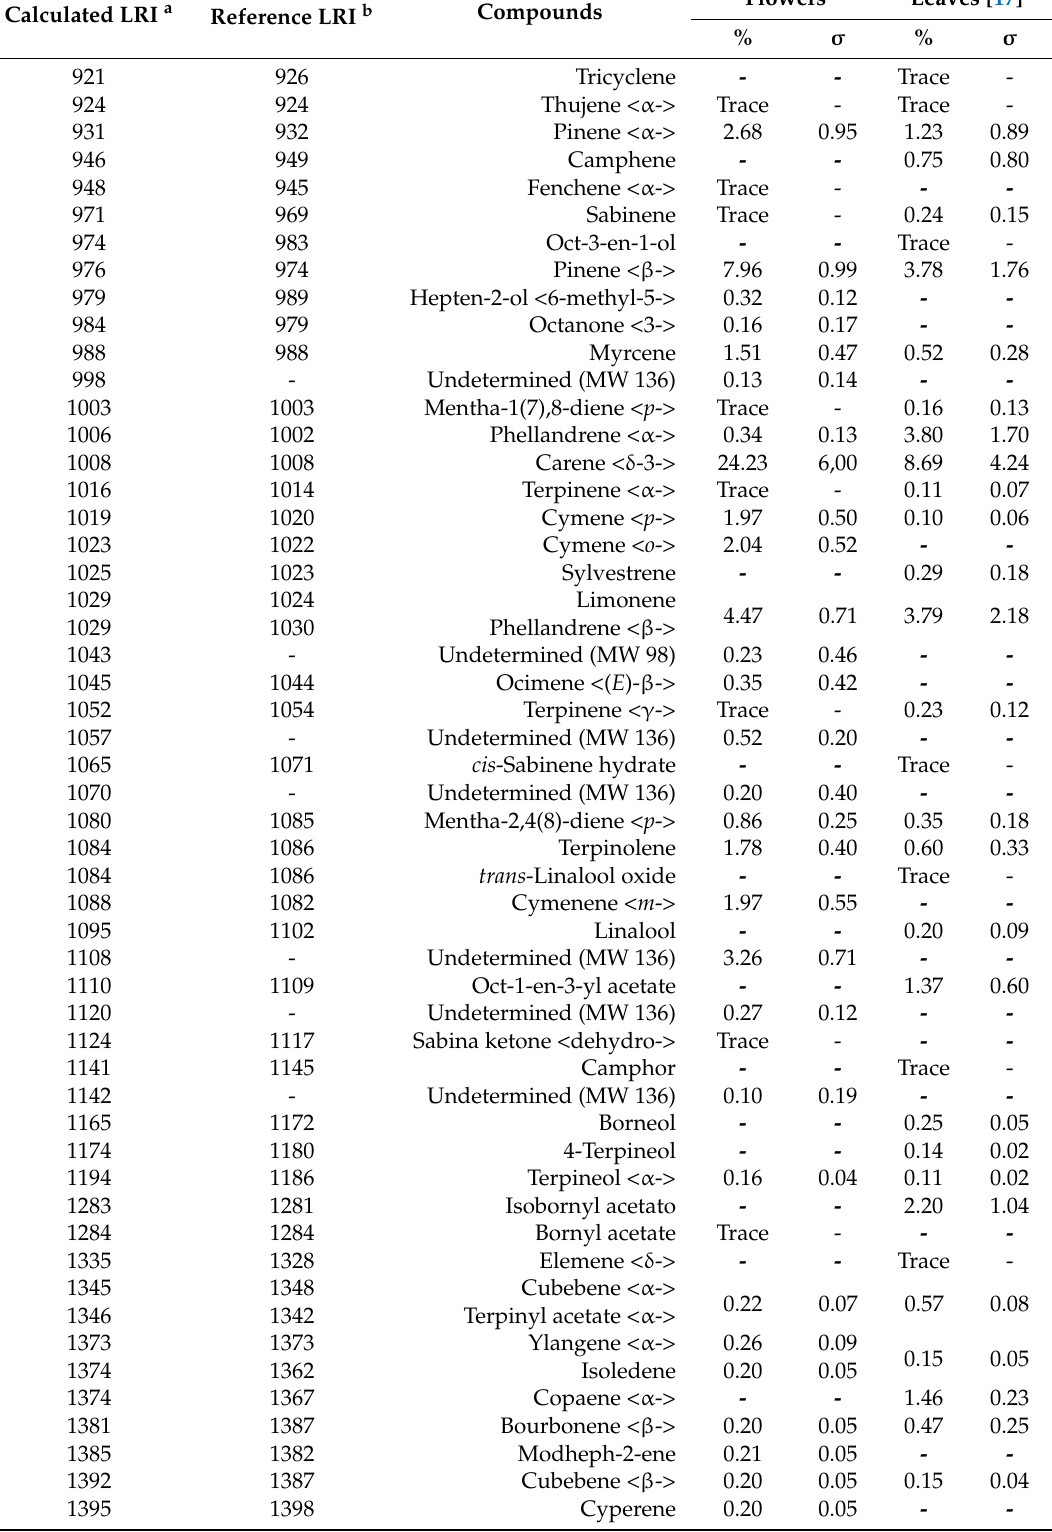
Table 1. Chemical composition of the essential oils from flowers and leaves of Lepechinia mutica on a DB-5 capillary